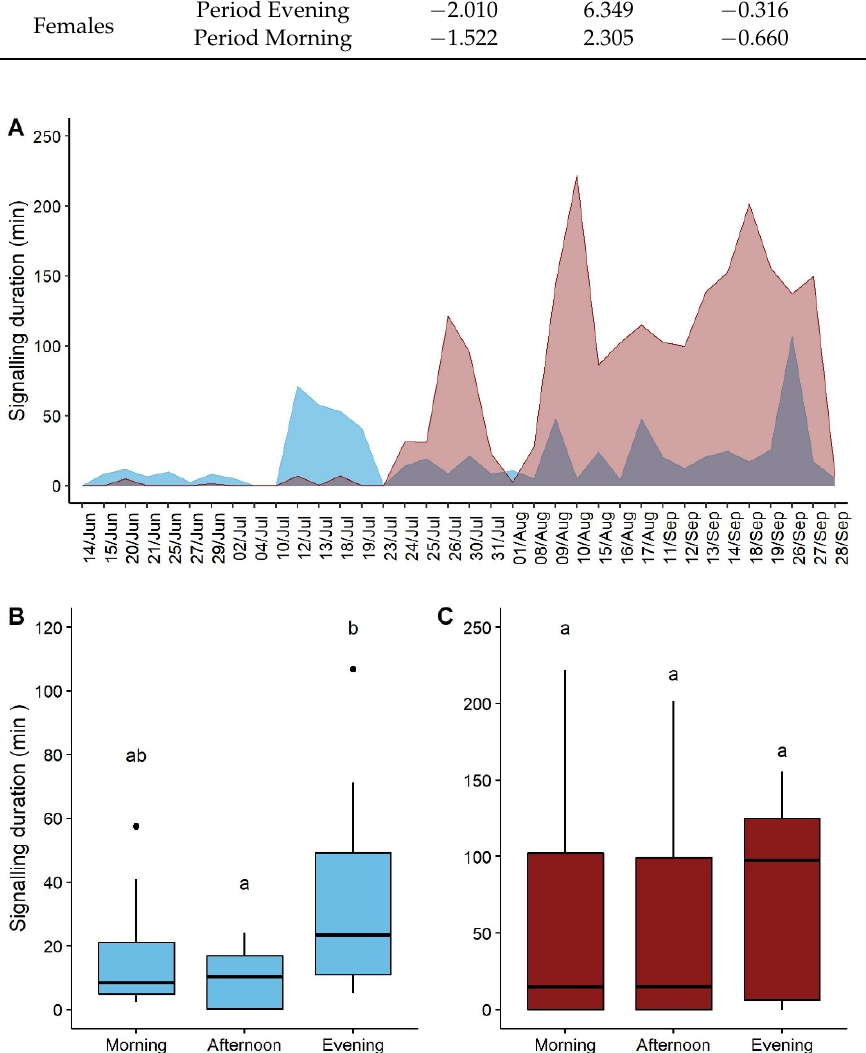
Figure 1. Vibrational signaling of males (blue) and females (red) of P. spumarius throughout the season and during the day: ( A ) Signaling duration per recording session of males and females; ( B ) Signaling duration of males per period of the day; ( C ) Signaling duration of females per period of the day indicate significant pairwise differences ( p < 0.05). Black spots indicate outliers. Different letters (a, b) indicate significant pairwise differences ( p -value < 0.05) between types of signals for each number of signaling